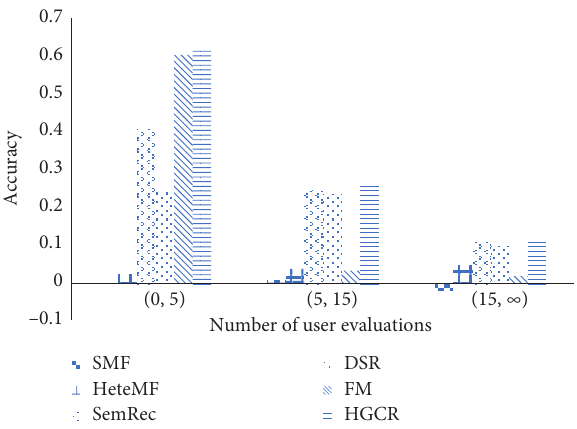
Figure 10: Performance of cold start on Douban Movie.